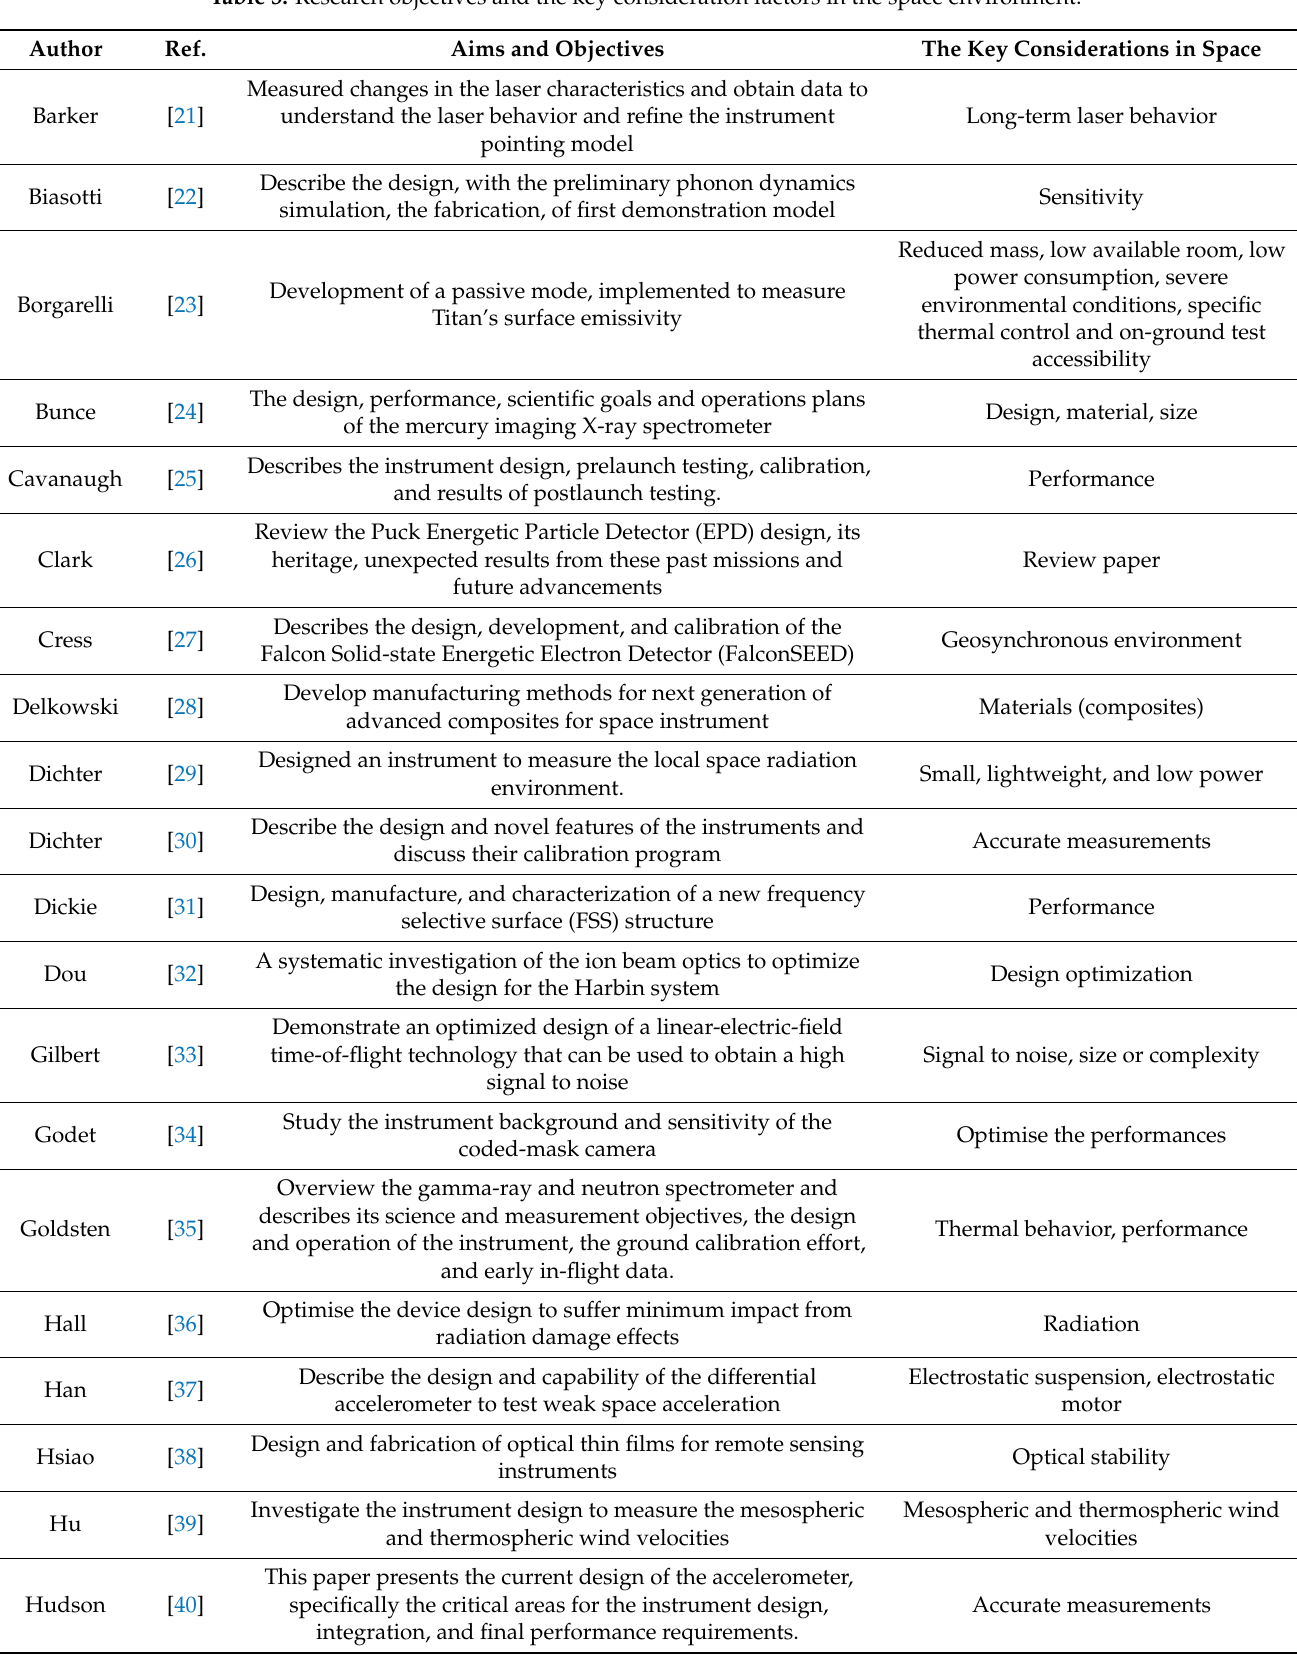
Table 3. Research objectives and the key consideration factors in the space